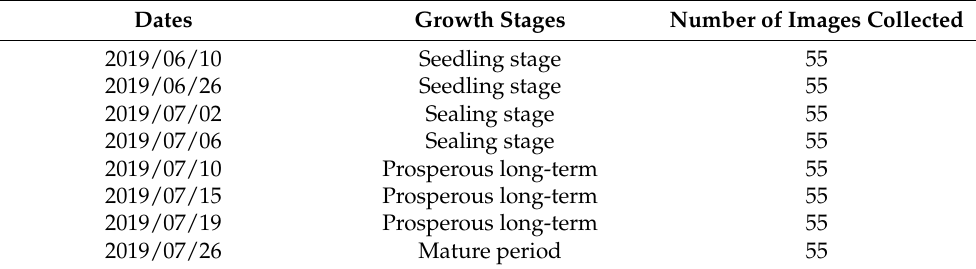
Table 1. The flight details during the whole growth